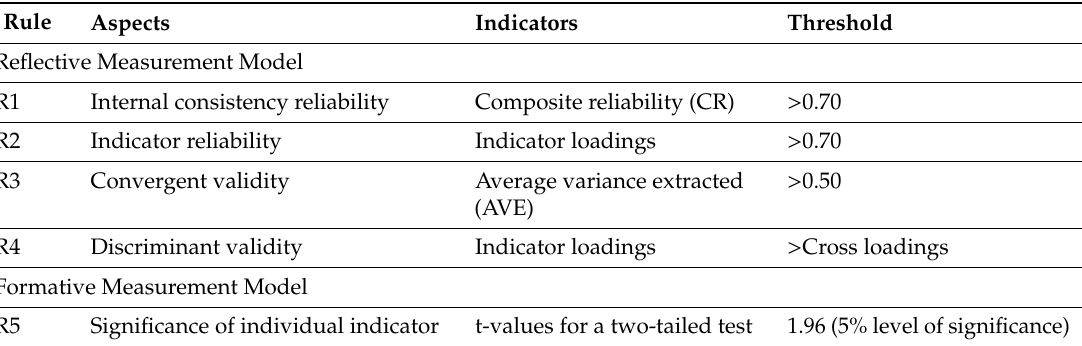
Table 4. Rules of Goodness-of-fit Assessment and Model Estimates.